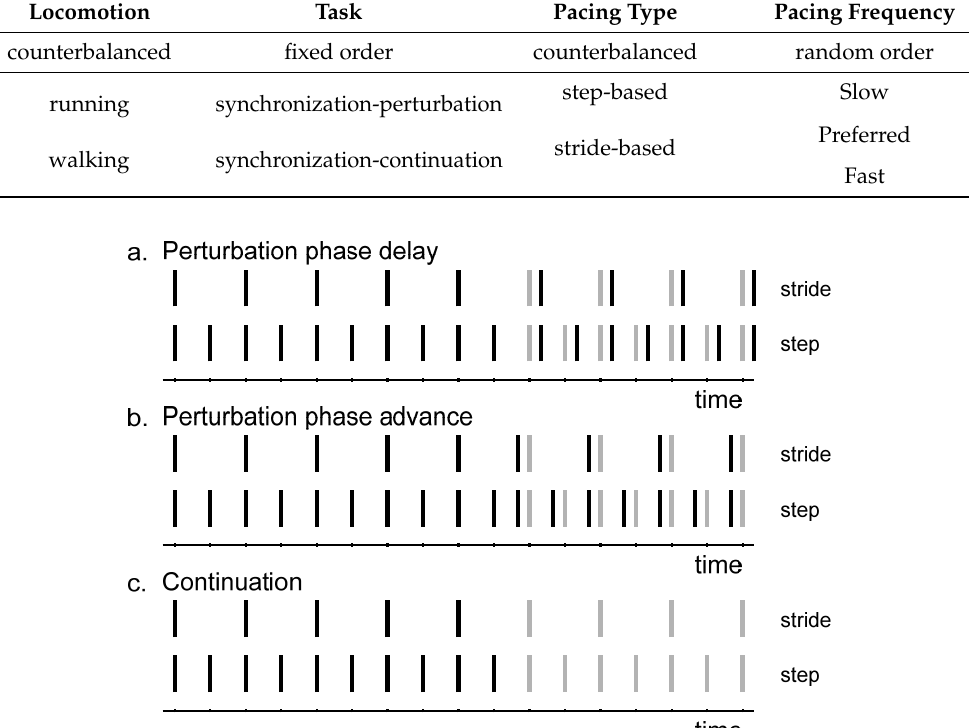
Figure 1. The synchronization-perturbation and synchronization-continuation tasks. Stride-based (upper) and step-based (lower) pacing rhythms are indicated by the vertical lines. ( a ) Phase-delay perturbations. The actual beep (black) comes later than expected according to the rhythm (grey). ( b ) Phase-advance perturbations. The actual beep (black) comes earlier than expected according to the rhythm (grey). ( c ) Continuation. The beeps no longer appear.